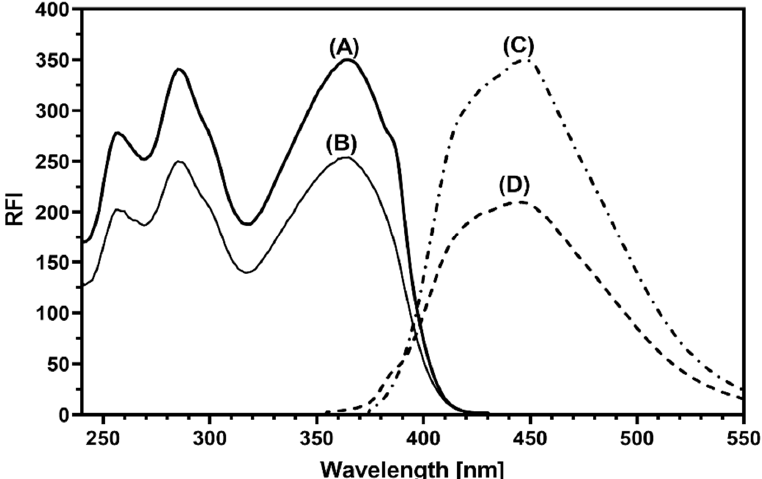
Figure 2. The excitation (A) and emission (C) spectra of ALC in a Cr RH 40 (1%, w / ν ) medium, and the excitation (B) and emission (D) spectra of ALC in aqueous media without Cr RH 40. The con ‐ centration of ALC in both cases was 250 ng mL − 1 .